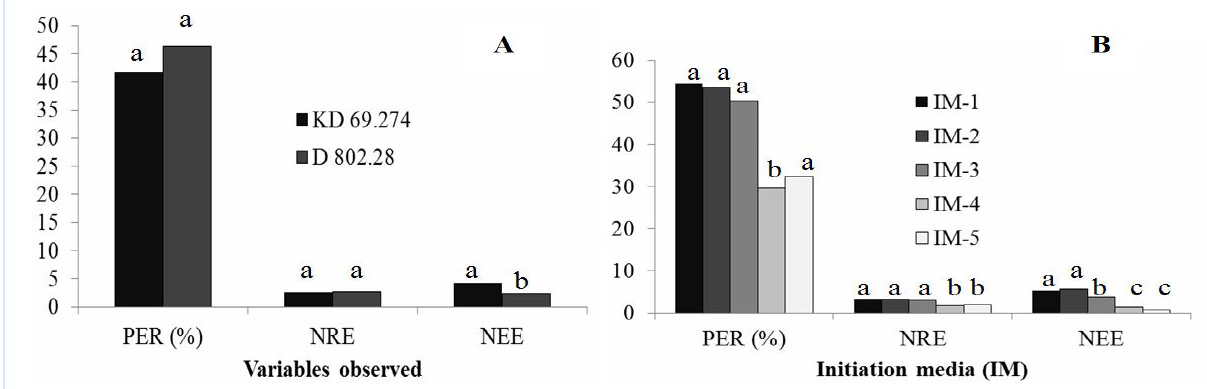
Fig. 1. Effect of clones (A) and initiation media (B) on embryo formation. PRE– percentage of explant regeneration (%); NRE– number of regenerated-explants; NEE– number of embryos per explant; IM-1– half-strength MS medium supplemented with 0.75 mg/L TDZ and 0.25 mg/L BA; IM-2– half-strength MS medium with full micro, Fe and vitamin containing 0.5 mg/L TDZ and 0.25 mg/L BA; IM-3– half- strength MS with full vitamin supplemented with 0.5 mg/L TDZ and 0.25 mg/L BA; IM-4 – half-strength MS medium with micro, Fe- chellate and vitamin augmented with 150 ml/L CW; IM-5– half-strength MS medium with full vitamin containing 150 ml/L CW. Means followed by the same letter in the same column were not significant different based on HSD ( p=0.05